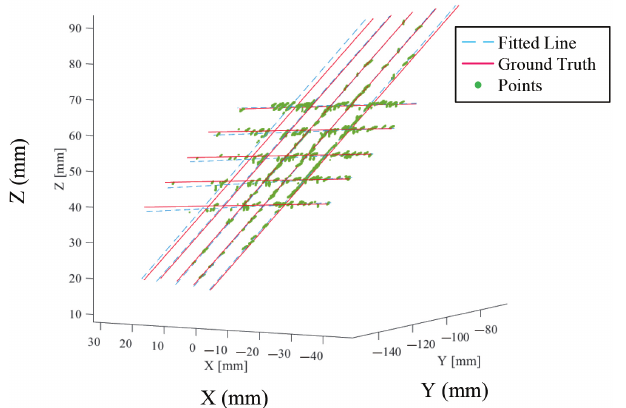
Figure 12. Validation of the US probe calibration. Red lines indicate the ground truth wires while blue lines are fitted lines. Green points are the points detected from the US